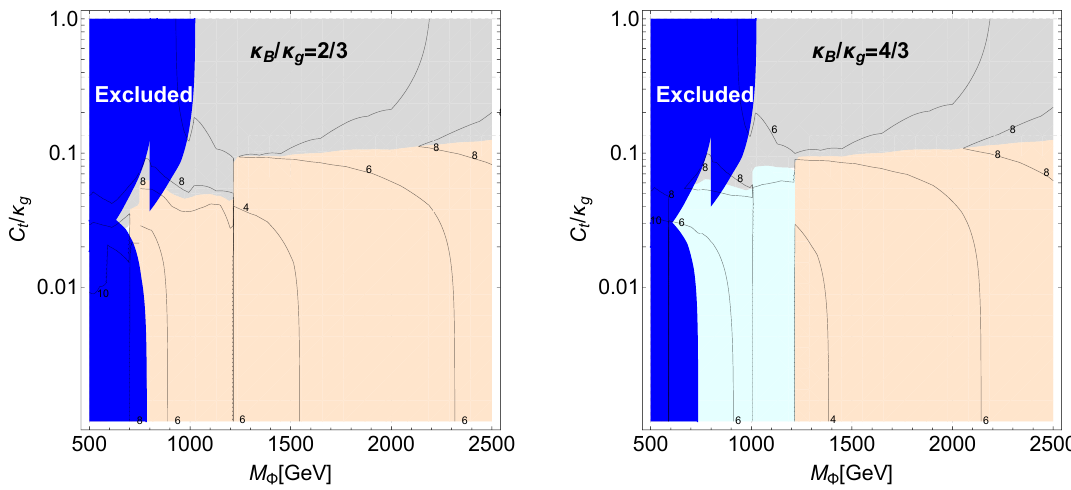
Figure 4 . Expected bounds on color octet single production in the M (cid:8) vs. C t =(cid:20) g plane for (cid:20) B =(cid:20) g = 2 = 3 and 4 = 3. The contours show the upper bound on (cid:20) g =f (cid:8) (in TeV (cid:0) 1 ). The dark-blue areas are excluded by pair production searches. In the grey areas, the strongest bound arises from t (cid:22) t resonance searches. In the orange (cyan) areas, the currently strongest bound arises from di-jet (jet- (cid:13) )